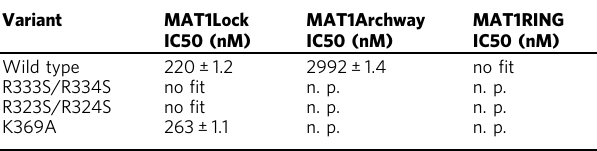
Table 2 Relative helicase activity inhibited by